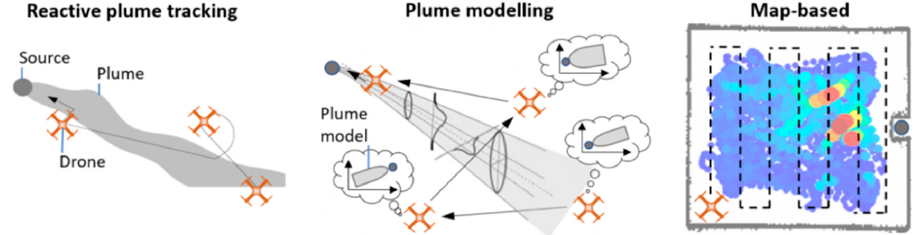
Figure 2. Gas source localization strategies. ( left ) Reactive plume tracking; ( center ) Plume modelling; ( right ) Map-based.